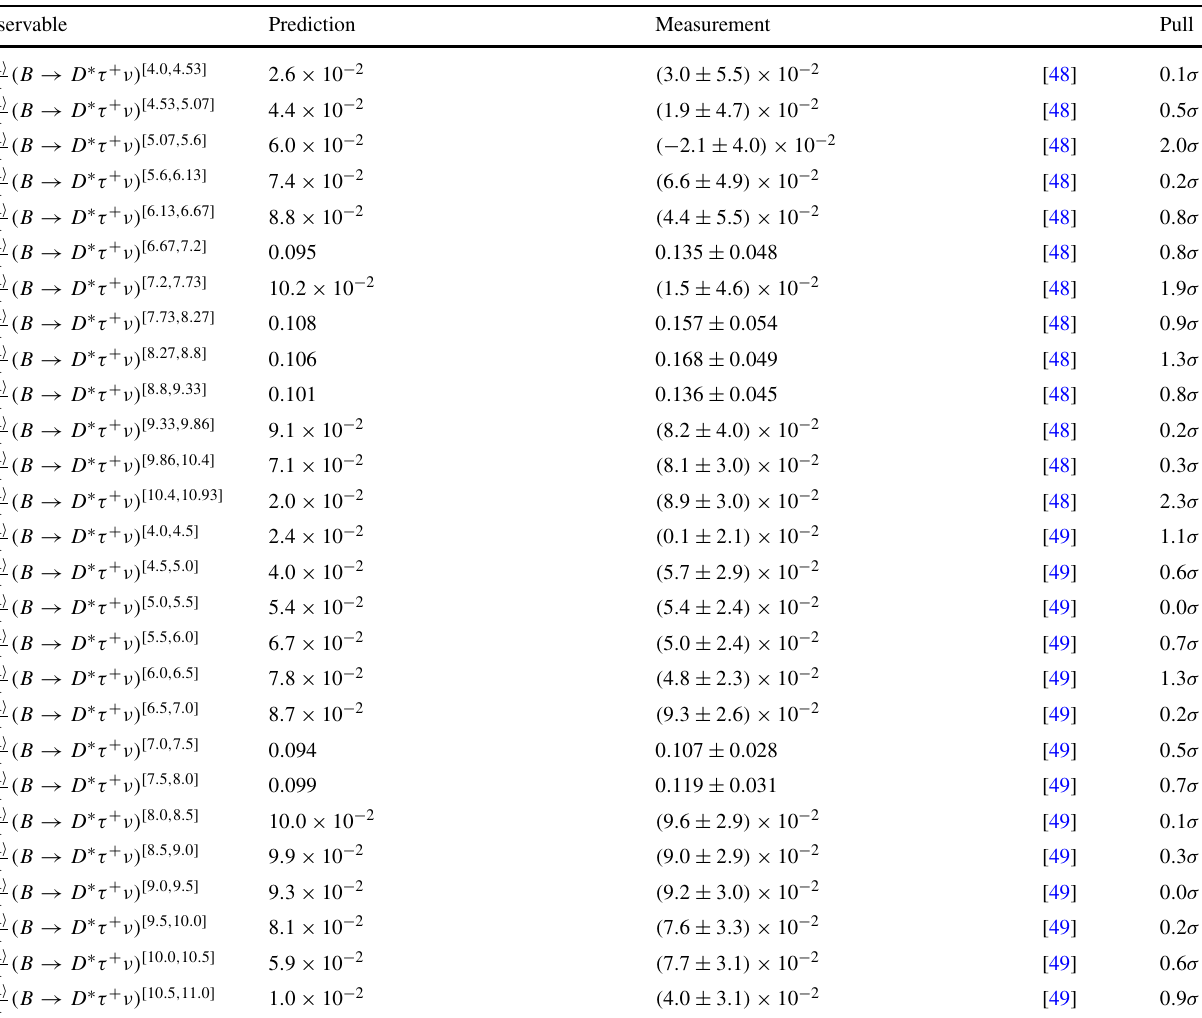
Table 5 Charged-current LFU-testing observables except R D ( ∗ )